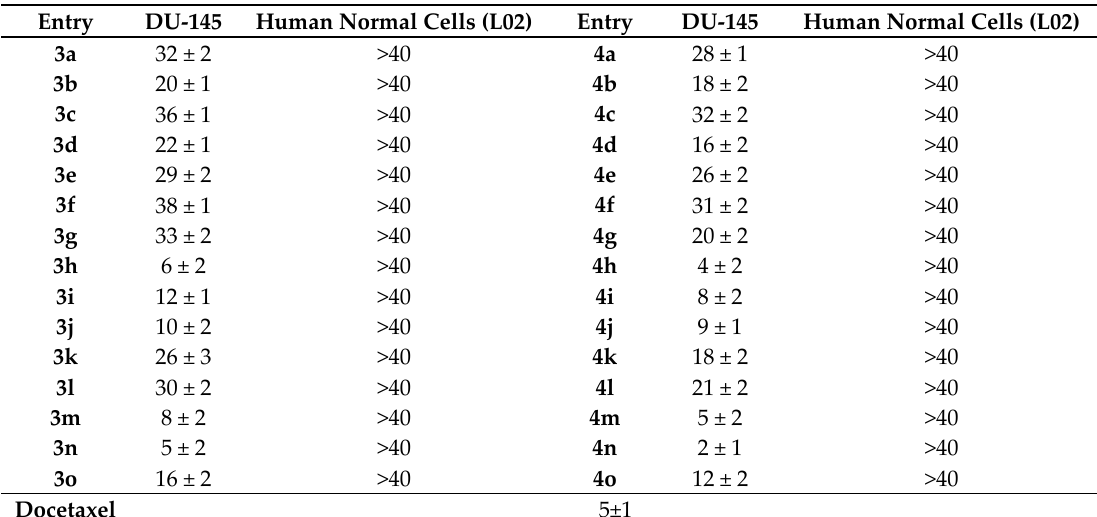
Table 4. Comparison of the MTT assay anticancer results of chalcones and pyrazolines. (IC50 values in